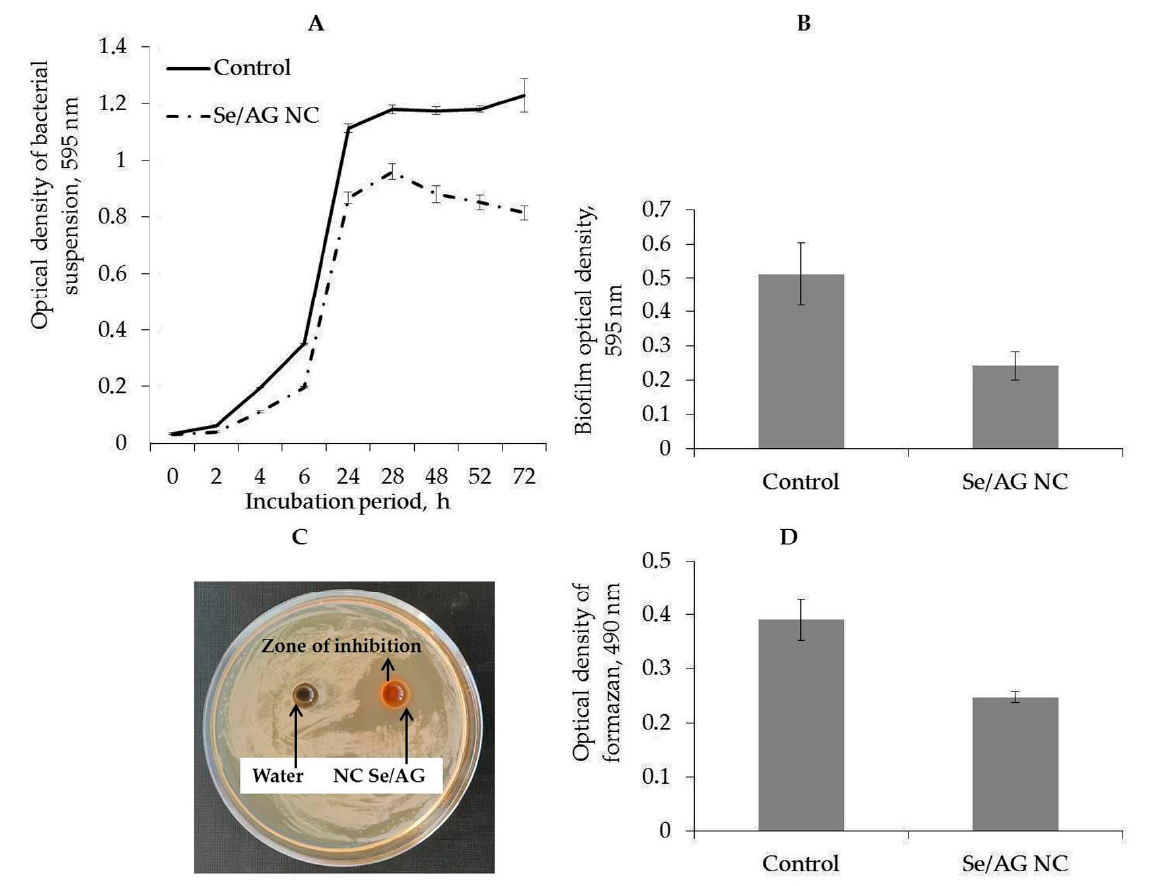
Figure 6. Effect of Se/AG NC on viability ( A ), biofilm formation after 24 h of incubation with Se/AG NC ( B ), growth ( C ), and dehydrogenase activity after 24 h of incubation with Se/AG NC ( D ) of Pectobacterium carotovorum .